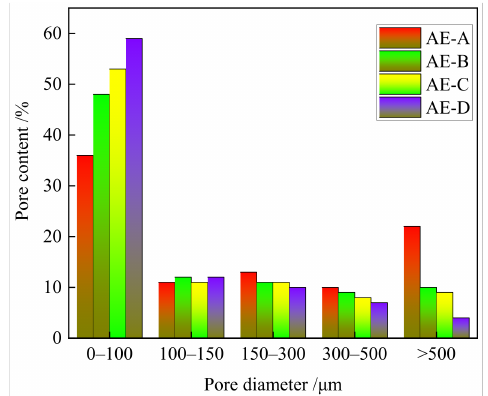
Figure 14. Bubble distribution in concrete.